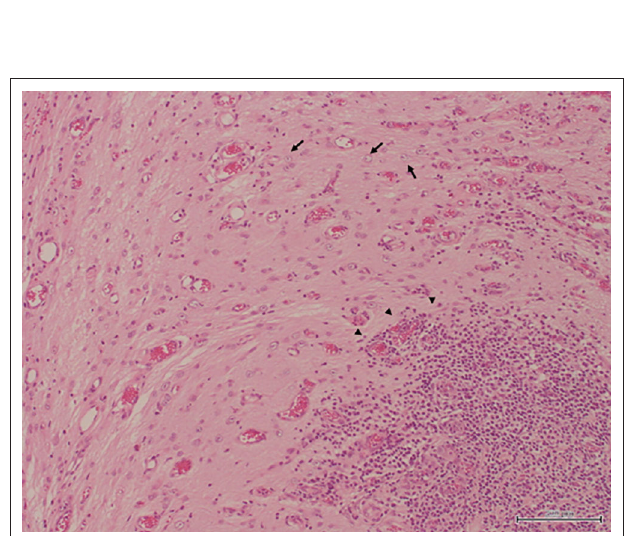
FIGURE 2 | Intraoperative photographs of the intranasal meningoencephalocele. After approaching the lesion by transfrontal craniotomy, a discolored mass connected to the brain was easily identified (A) . After resecting the mass the defect was covered with the sections of the tunica vaginalis which were further covered by fibrin glue (B) .